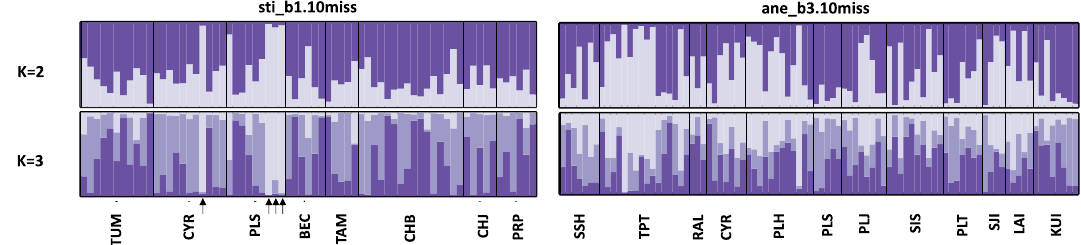
Figure 4. STRUCTURE plots of S. haddoni (sti_b1.10miss) and E. quadricolor (ane_b3.10miss) suggest a single genetic cluster across all the sampling localities in Singapore. Sites are arranged in a west-to east-ward order starting from Tuas Merawang (TUM) for S. haddoni , and Sultan Shoal (SSH) for E. quadricolor . The four diverging individuals are indicated with arrows.